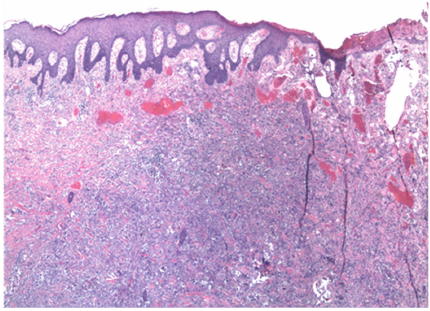
Figure 2: Section of skin showing malignant cells infiltrating the epidermis and dermis but without subcutaneous invasion (H&E 5x).